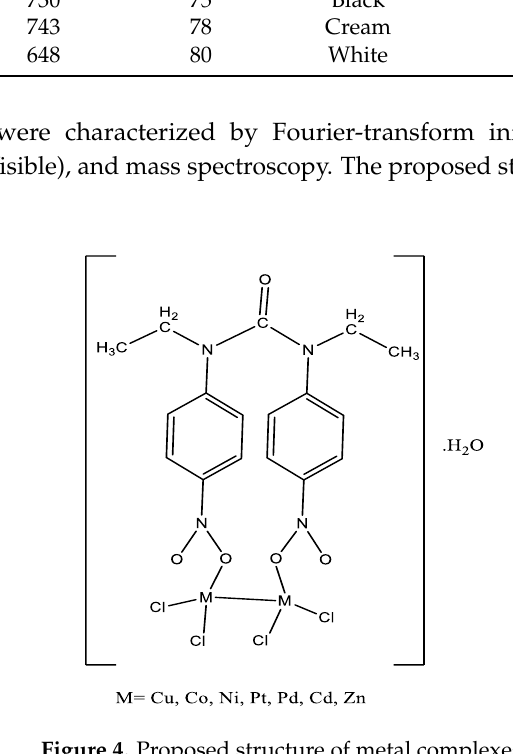
Table 2. Physical properties of Ligand (L) and its metal complexes.